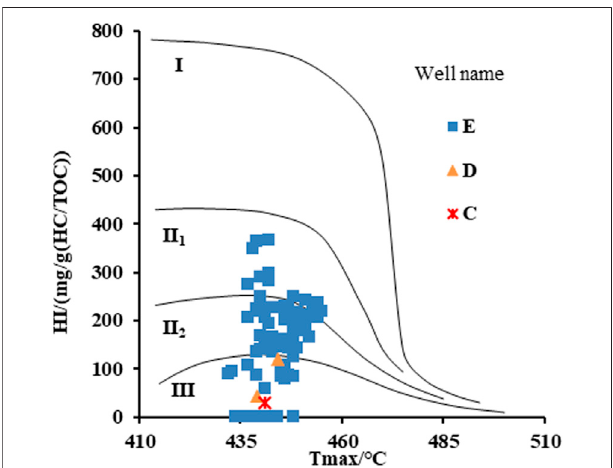
FIGURE 6 | Plot of the hydrogen index (HI) versus